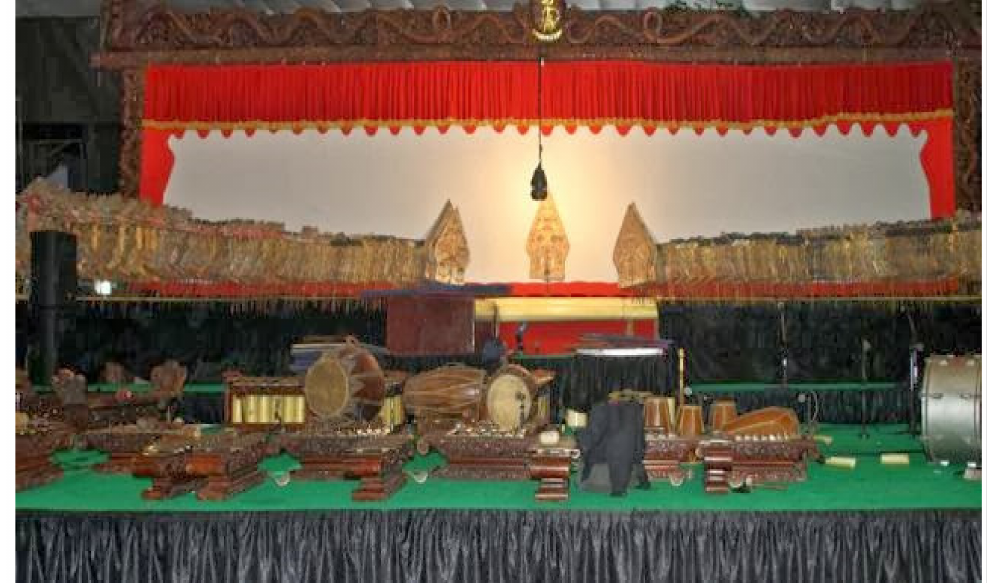
Figure 1. Puppet kelir seen from the front. Source: https://id.m.wiktionary.org/wiki/kelir#/media/ Berkas%3Akelir.jpg (accessed on 17 September